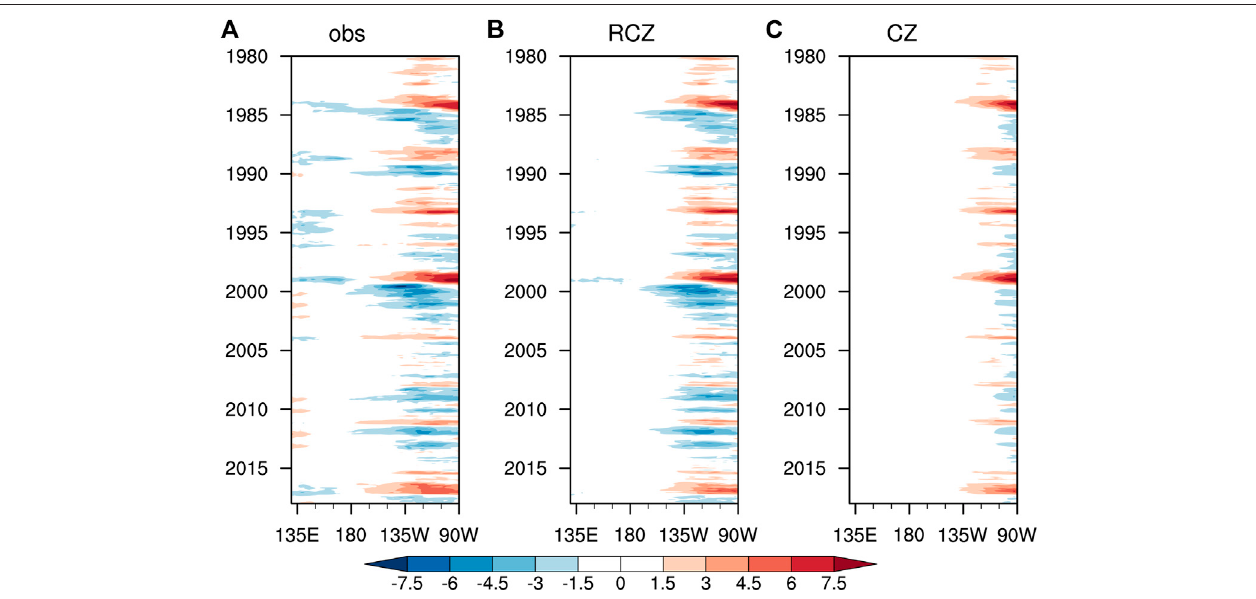
FIGURE1| (A) Timeevolution ofthe observed equatorial (5 ° S – 5 ° Naverage)subsurfacetemperatureanomalies (unit: ° C) over thePaci fi cduring 1980 – 2018. (B,C) Sameas (A) butforsubsurfacetemperatureanomaliesparameterizedthrough Eq.2 and EquationsA12andA13 inZC87,respectively.Thesubsurfacetemperatureis de fi ned as the temperature at the depth of H sub (cid:1) 75 m . Ocean temperature and 20 ° C-isotherm depth are from the ECMWF ORAS5 dataset.